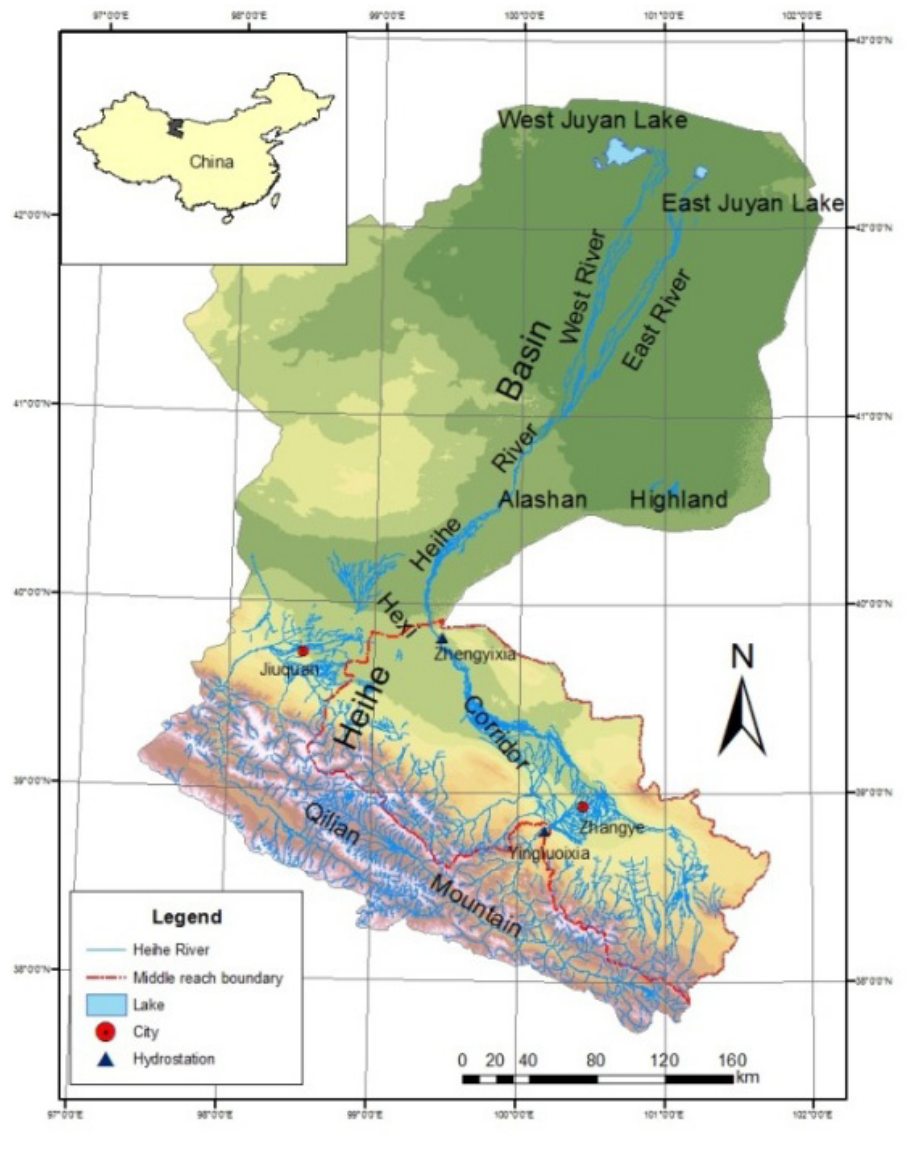
Figure 1. The boundary of the Heihe River Basin in Northwest